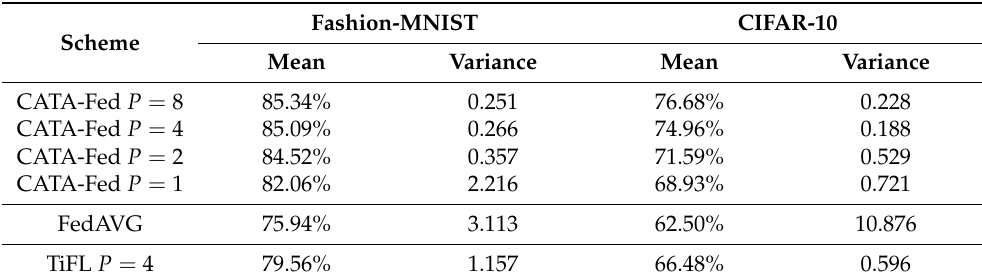
Figure 12. Test set accuracy vs. global iterations for ( a ) MNIST, ( b ) Fashion-MNIST, and ( c ) CIFAR-10 under the condition of in non-IID setting with the number of cluster P = [ 1,2,4,8 ] , deadline T = 1, the number of biased class H = 1. Table 3. Mean and variance of accuracy values of last 50 rounds of global